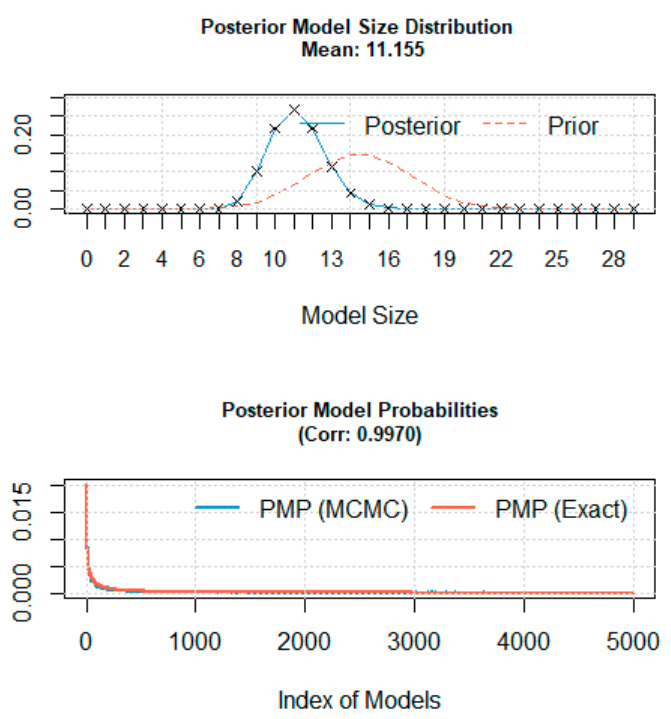
Figure A1. BMA Posterior Model Size Distribution and Probabilities.